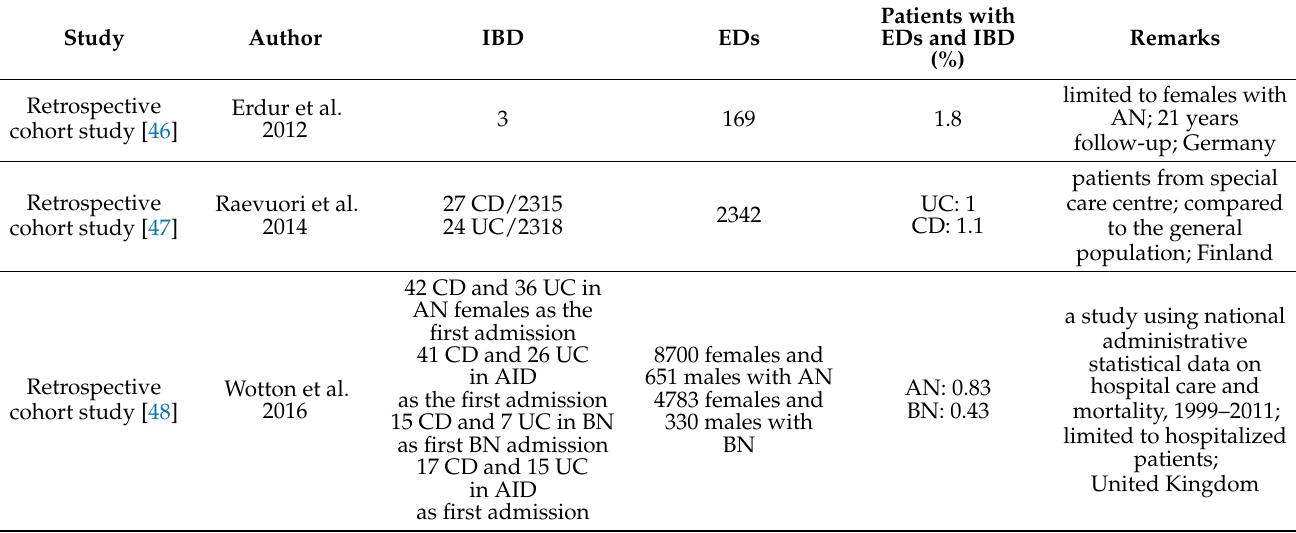
Table 2. Inflammatory bowel disease in eating disorders